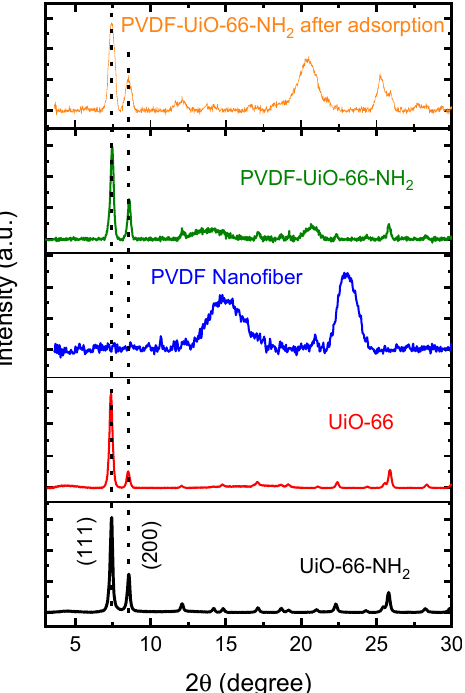
Figure 2. Patterns of XRD for UiO-66-NH 2 , UiO-66, PVDF nanofiber, and UiO-66-NH 2 CNM prior to and following adsorption at pH 12.